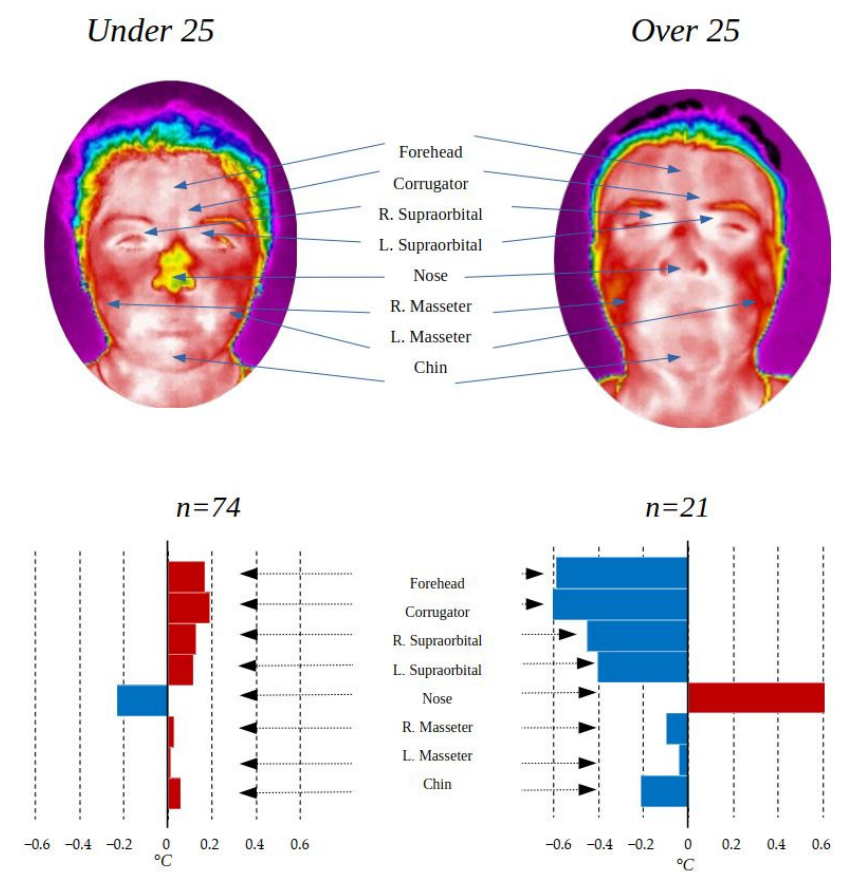
Figure 7. ROI comparison by age.